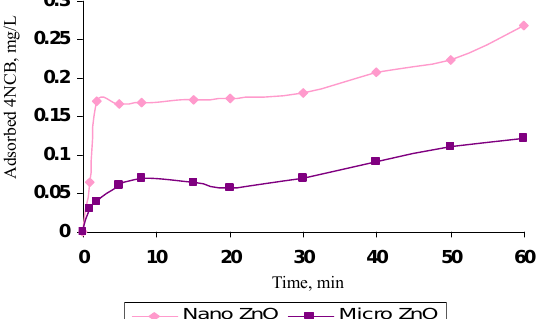
Figure 4. Evolution of the remaining concentration of 4NCB during catalytic ozonation at different ZnO particle size, [4CNB] pH= 7.11.